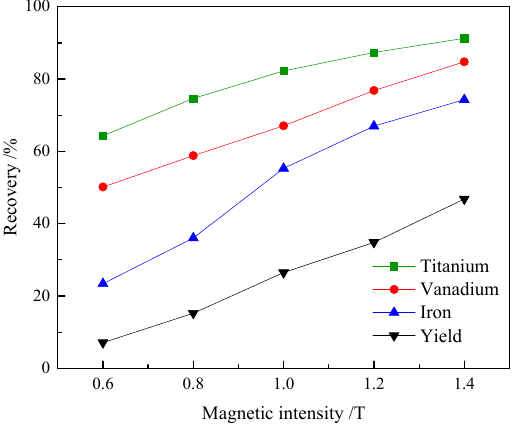
Figure 4. The effect of magnetic intensity on the pre-discarding tailing.